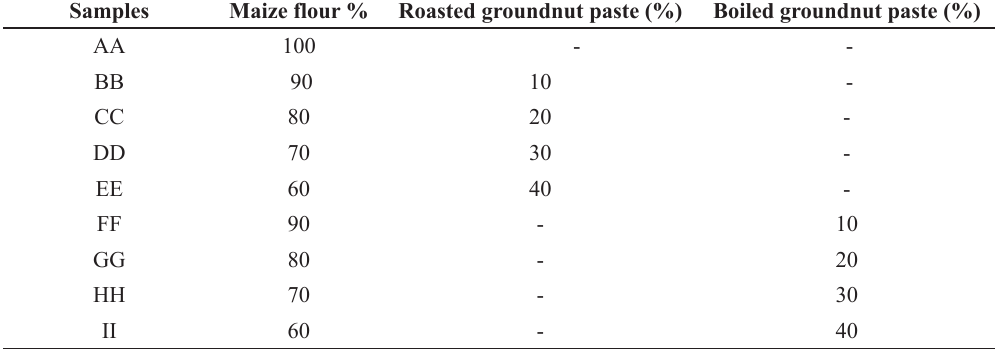
Table 1: Blends of Maize Flour and Groundnut Paste for the Production of snacks of different blends of maize and groundnut. Samples Maize flour % Roasted groundnut paste (%) Boiled groundnut paste